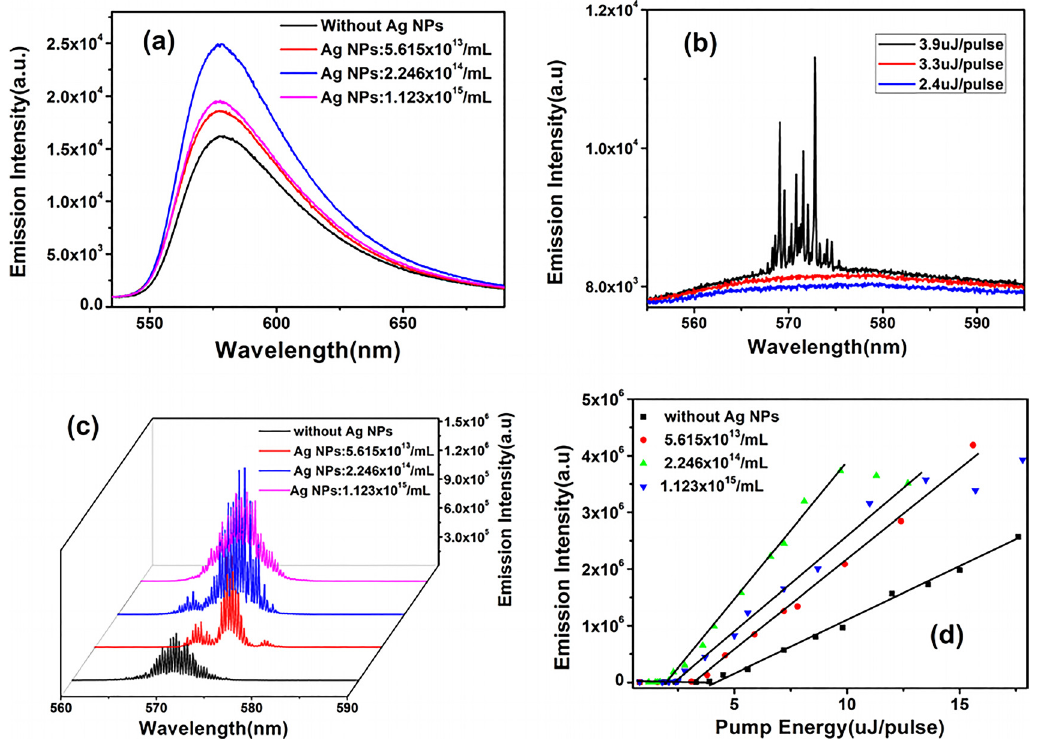
Figure15: (a)EmissionspectraoffluorescencefromthetoluenesolutionofPM597laserdyescontainingdifferentAgNPconcentrationsunder thepumpenergyof32.4µJ/pulse.(b)EmissionspectraasafunctionofpumpenergyfortheNP-freeDDNLC.(c)EmissionspectraofRLfromthe NPDDNLC with different Ag NP concentrations under the pump energy of 7.2 µJ/pulse. (d) The threshold energy curves of RLs from the DDNLC with the addition of different Ag NP concentrations